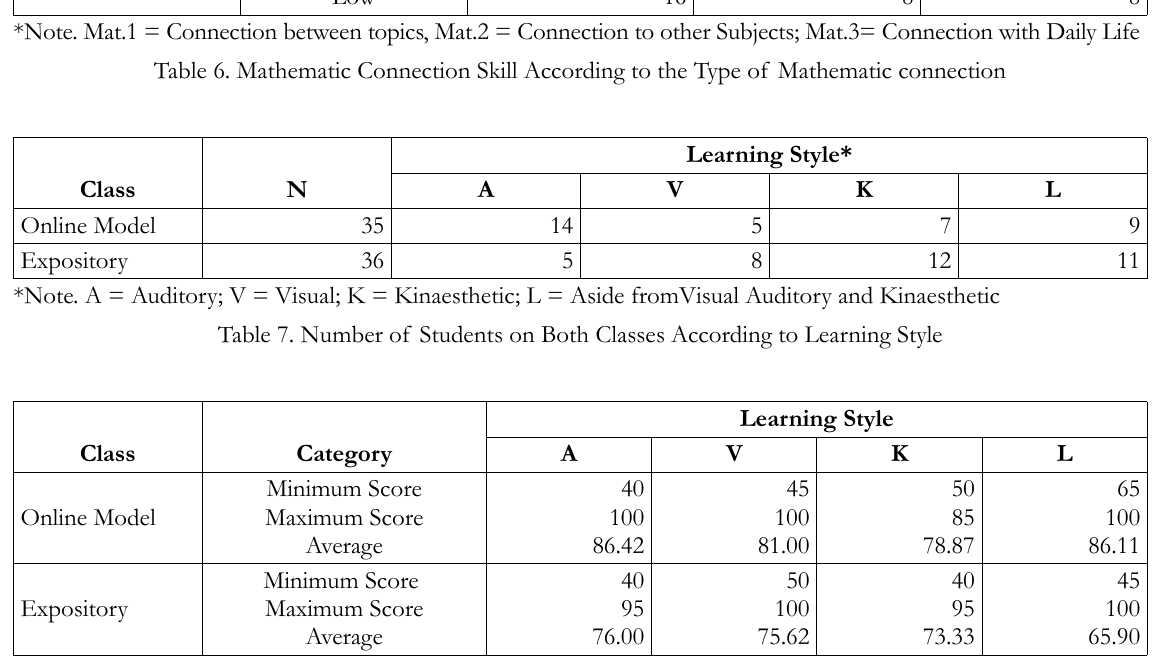
Table 8. Mathematic connection of Students based on Learning